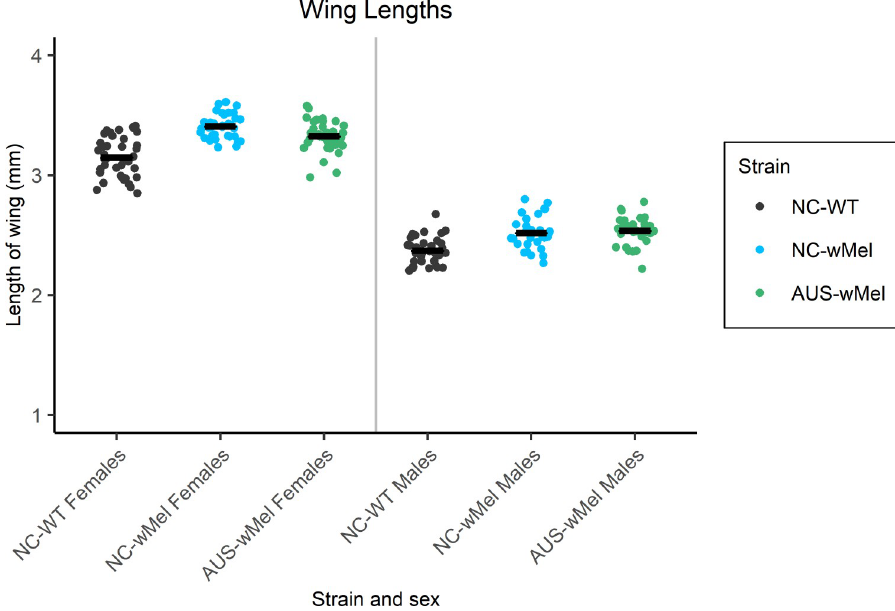
Fig 3. Mean wing lengths for males and females of NC- w Mel, AUS- w Mel, and NC-WT strains. Wing lengths were calculated as the distance from the wing base to the wing tip, on 30 to 40 specimens of each sex and strain. Each point represents the length of a mosquito’s wing. The black bars represent the mean of wing lengths per